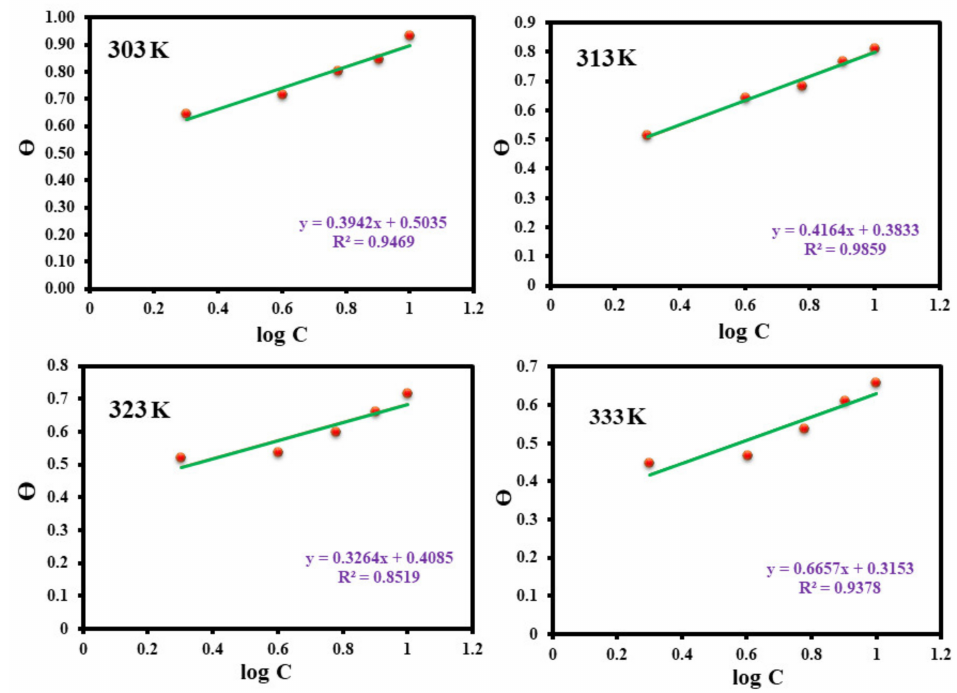
Figure 5. Temkin adsorption isotherm for the inhibition effect of aqueous leaf extract of SA on mild steel corrosion in 1.0 M HCl at different